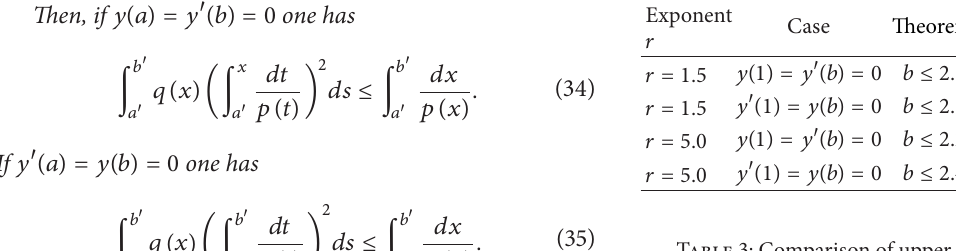
Table 3: Comparison of upper bounds for 𝑏 in Example 14.